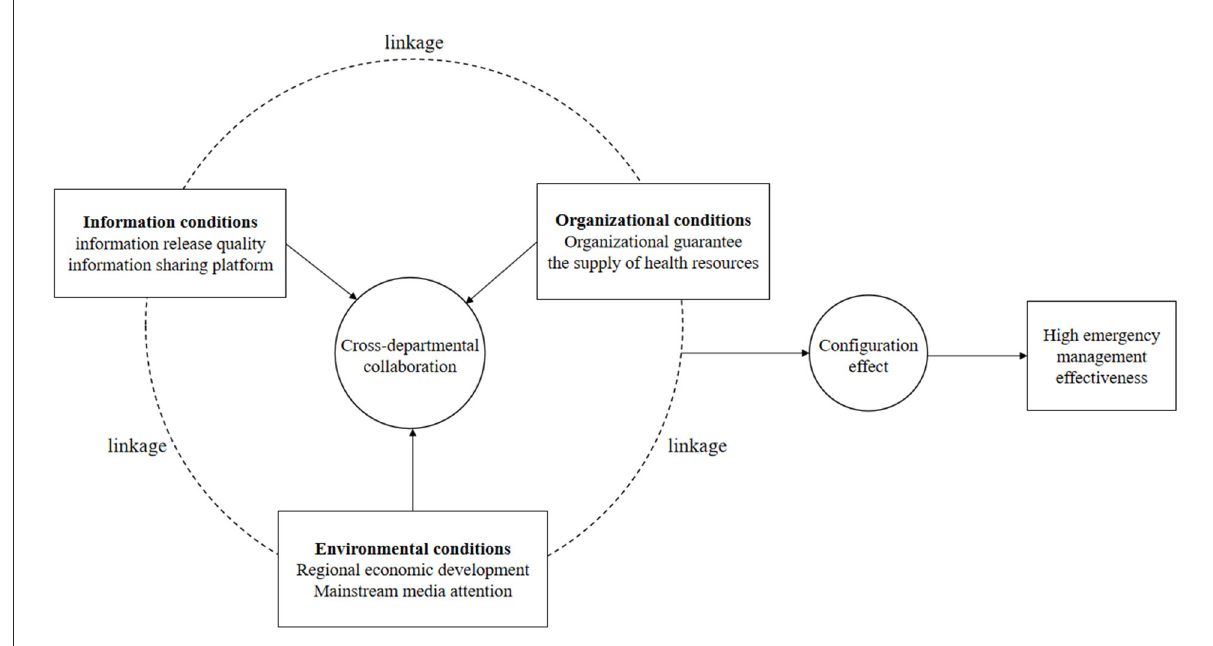
FIGURE1 Theoretical analysis